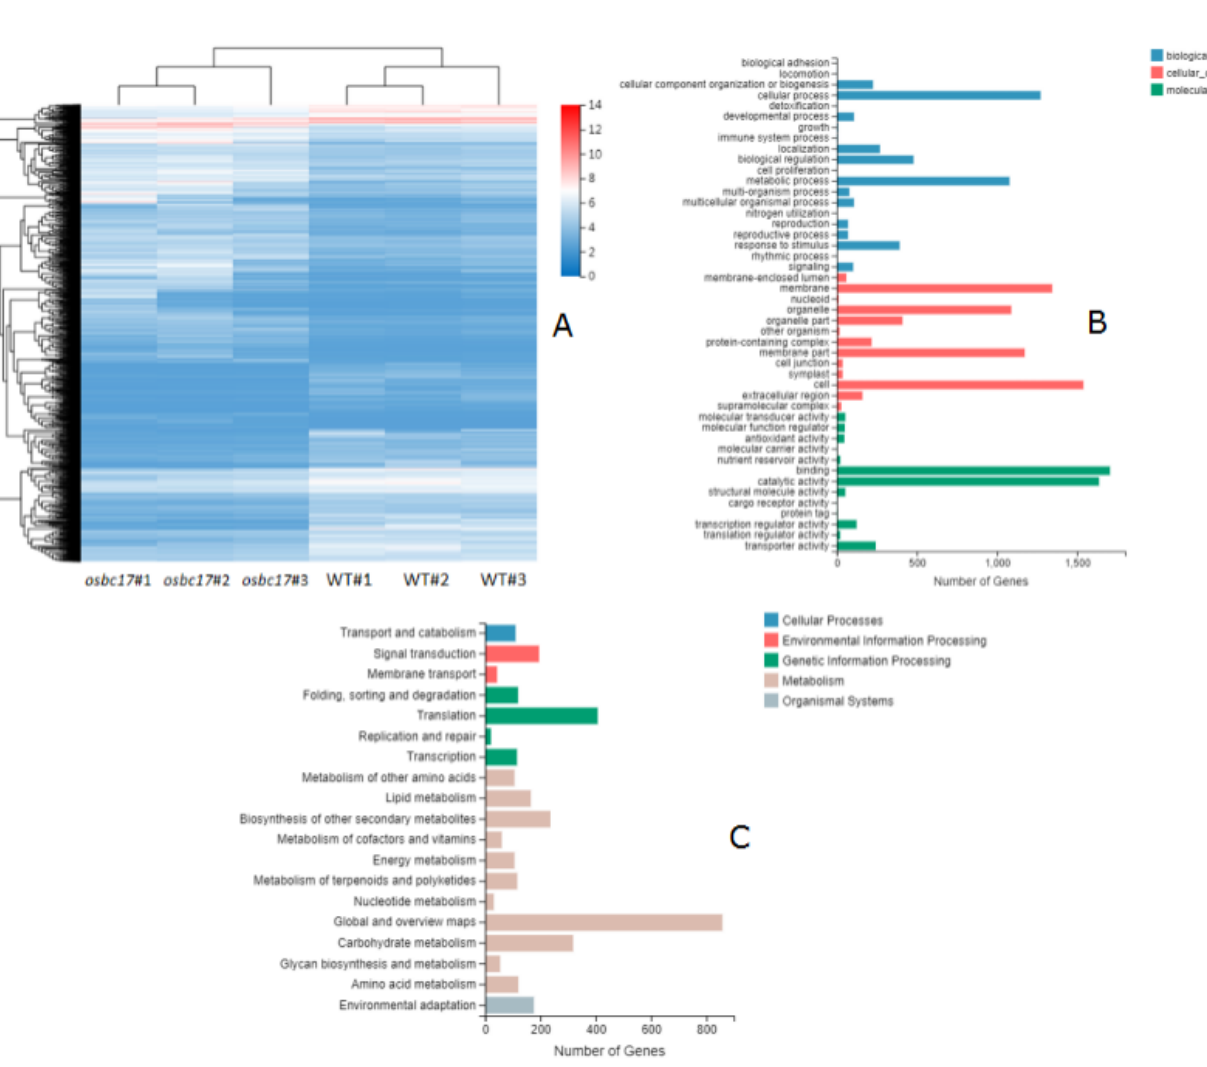
Figure 7. ( A ) Clustering heat map of differential gene expression. ( B ) GO classification of differential genes. Transverse axis: number of genes; longitudinal axis: Gene Ontology. ( C ) KEGG pathway classification of differential genes. Transverse axis: number of genes; longitudinal axis: KEGG pathway.